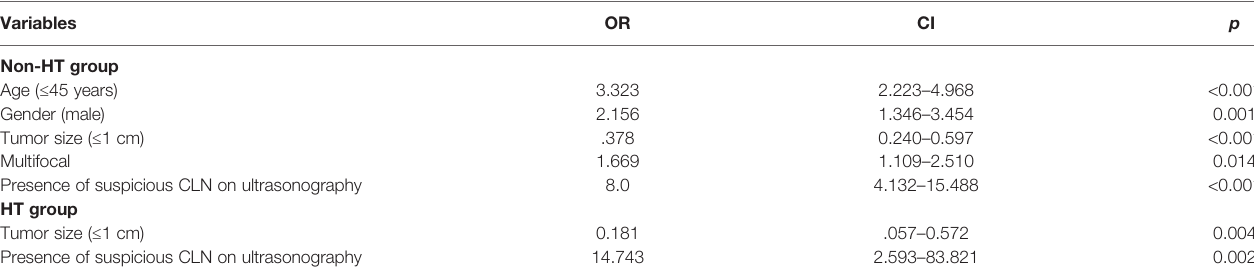
TABLE 6 | Multivariate analysis of the correlation between clinical factors of the primary tumor and rate of CLNM in HT and non-HT patients.